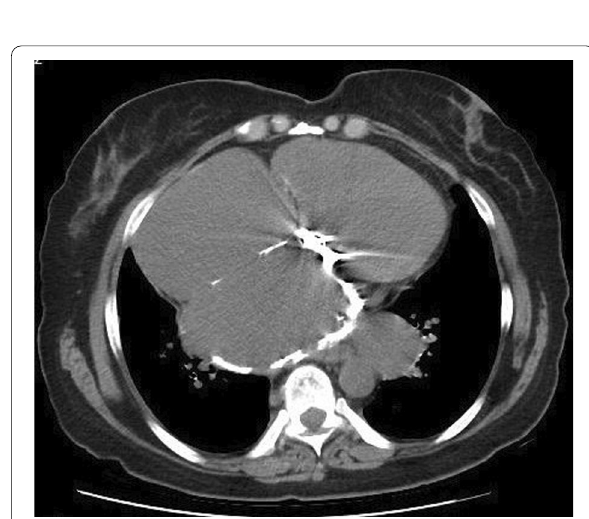
Fig. 2 Axial chest CT scan (mediastinal window) shows extensive left atrial wall and interatrial septal calcification along with biatrial enlargement. Mitral metallic prosthetic tricuspid valve is also seen. Metallic tricuspid prosthetic valve is not